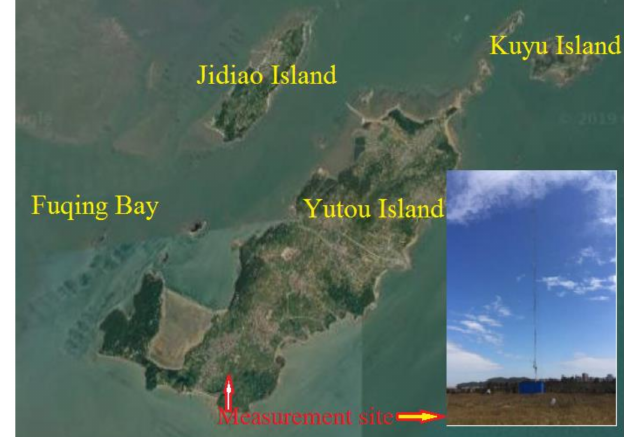
Figure 1. Location of the measurement site.